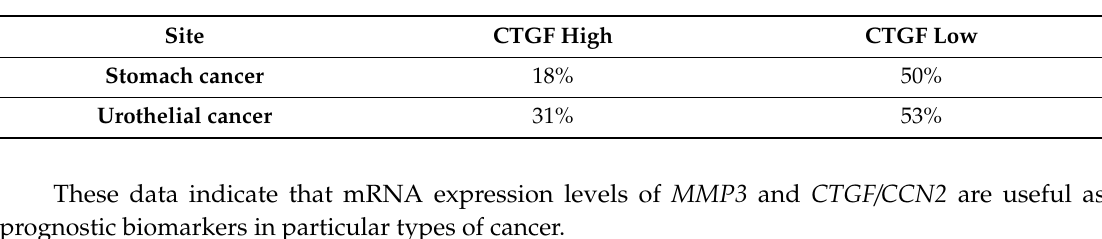
Table 6. Five-year survival in CTGF-high vs. -low expression